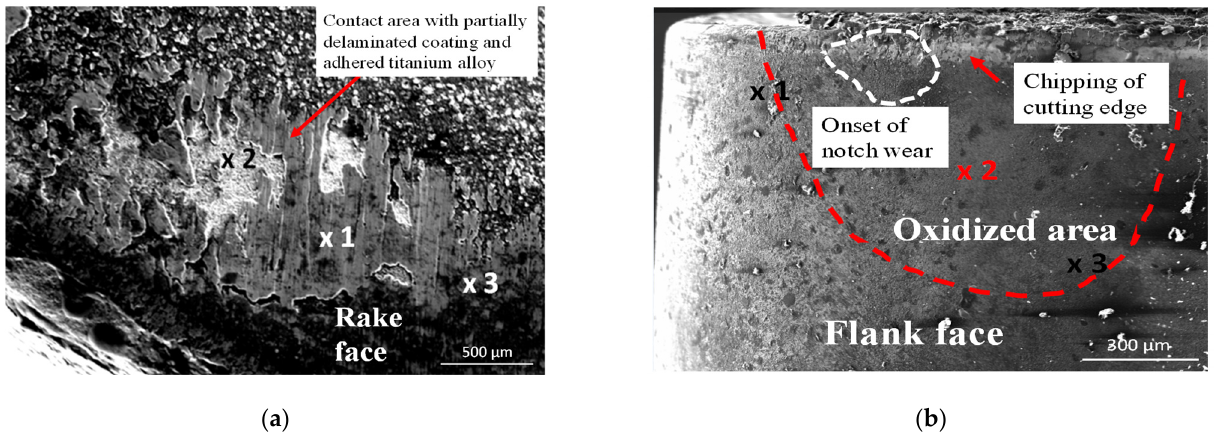
Figure 9. SEM images of rake ( a ) and flank ( b ) faces obtained after machining of Ti6Al4V workpiece with the cutting speed of 200 m/min; machining time of 30 s.